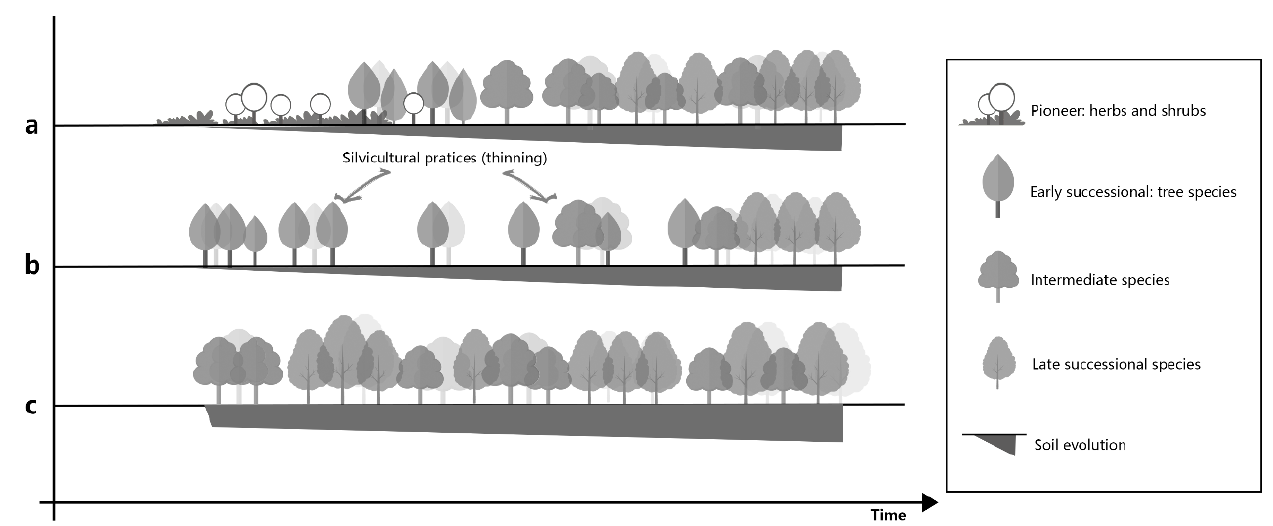
Figure 8. Schematic diagram of plant community succession. Note: ( a ) Natural succession methods; ( b ) traditional reforestation methods; ( c ), palustrine silvicultural succession methods.